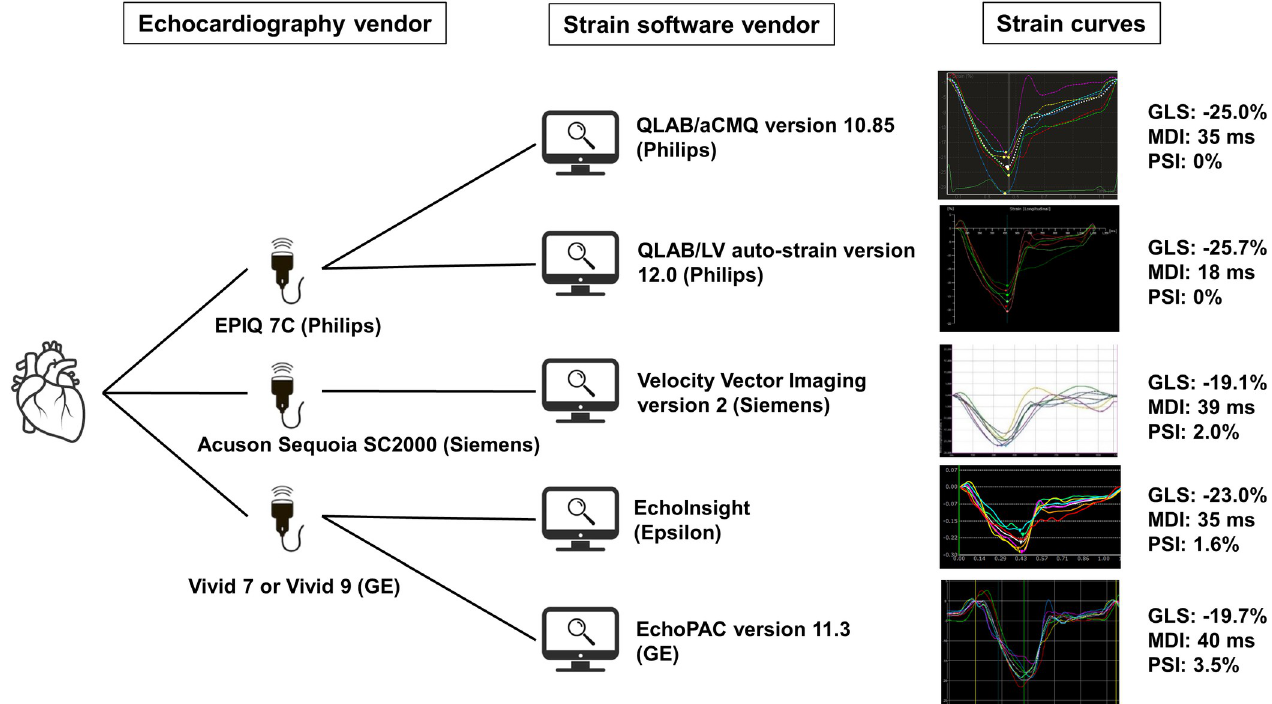
Fig 1. Echocardiographic scanner and analytic software used in this study with example strain curves from one patient reporting global longitudinal strain (GLS), mechanical dyssynchrony index (MDI) and post-systolic shortening index (PSI). https://doi.org/10.1371/journal.pone.0273419.g001 PLOS ONE | https://doi.org/10.1371/journal.pone.0273419 August 25,